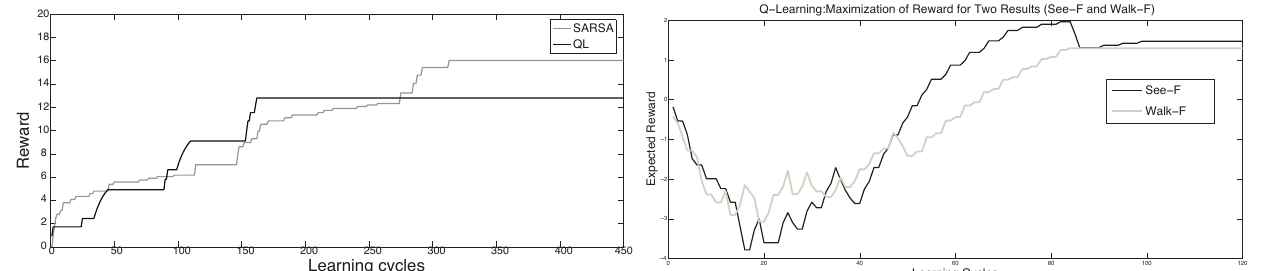
Figure 3. Comparing the performance of Q- and SARSA- learning in simula- tion.